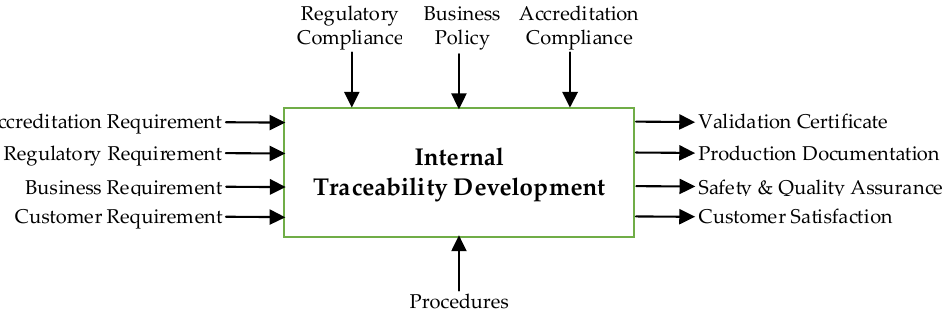
Figure 3. Integrated definition modeling (IDEF‐0) for internal traceability development.